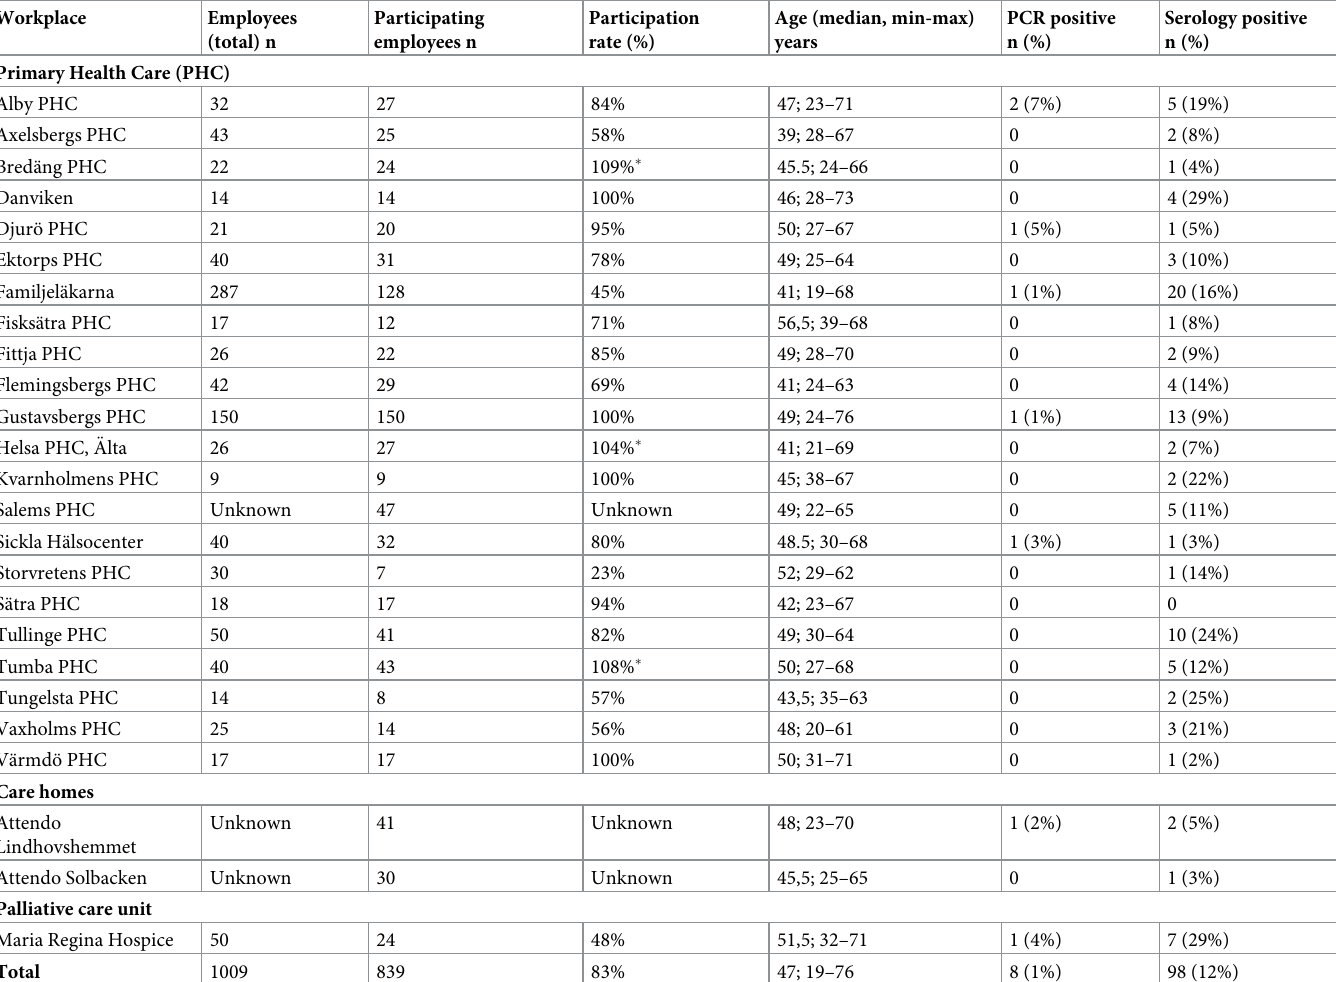
Table 1. Descriptive statistics for workplaces included in the study and distribution of SARS-CoV-2 testing results by workplace.